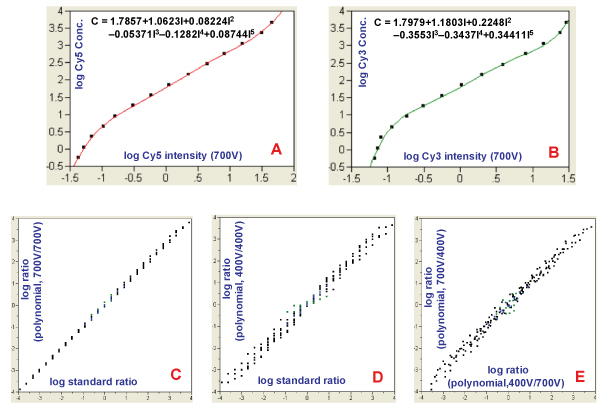
Correction of ratio bias by calculating ratios from the estimated concentrations from the calibration curves. A: Polynomial fitting of c = f(I) for Cy5 at 700 V gain; B: Polynomial fitting of c = f(I) for Cy3 at 700 V gain; C: log standard ratios versus log ratios calculated from concentrations estimated from the calibration curves (Cy5/Cy3 PMT gains at 700 V/700 V); D: log standard ratios versus log ratios calculated from concentrations estimated from the calibration curves (Cy5/Cy3 PMT gains at 400 V/400 V); E: log ratios calculated from concentrations estimated from the calibration curves under Cy5/Cy3 PMT gains at 400 V/700 V and 700 V/400 V, respectively. Data were from the scanner calibration slide. The effectiveness of concentration-based ratio calculation is more obvious by comparing Figures 10C, 10D and 10E to Figures 5B, 5A and 5F, respectively.